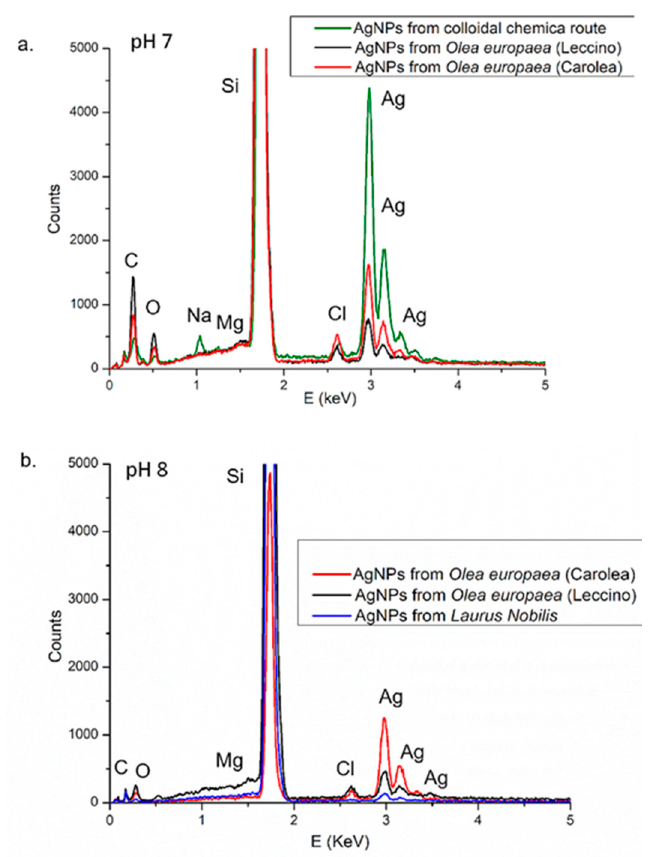
Figure 5. EDS measurements of AgNPs obtained from colloidal chemical route, from Leccino cultivar and Carolea at pH 7 ( a ) and from Leccino cultivar, Carolea cultivar and Laurus Nobilis at pH 8 ( b ).